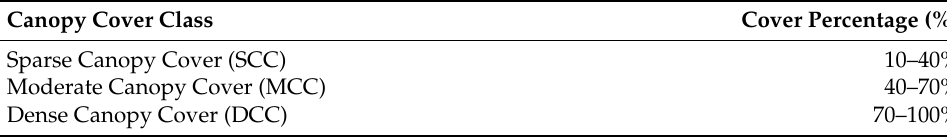
Figure 3. Distribution of filtered segments across the study area (ESRI World Imagery Basemap). Table 2. Canopy cover classes based on Turkish forest management practices [52]. Canopy Cover